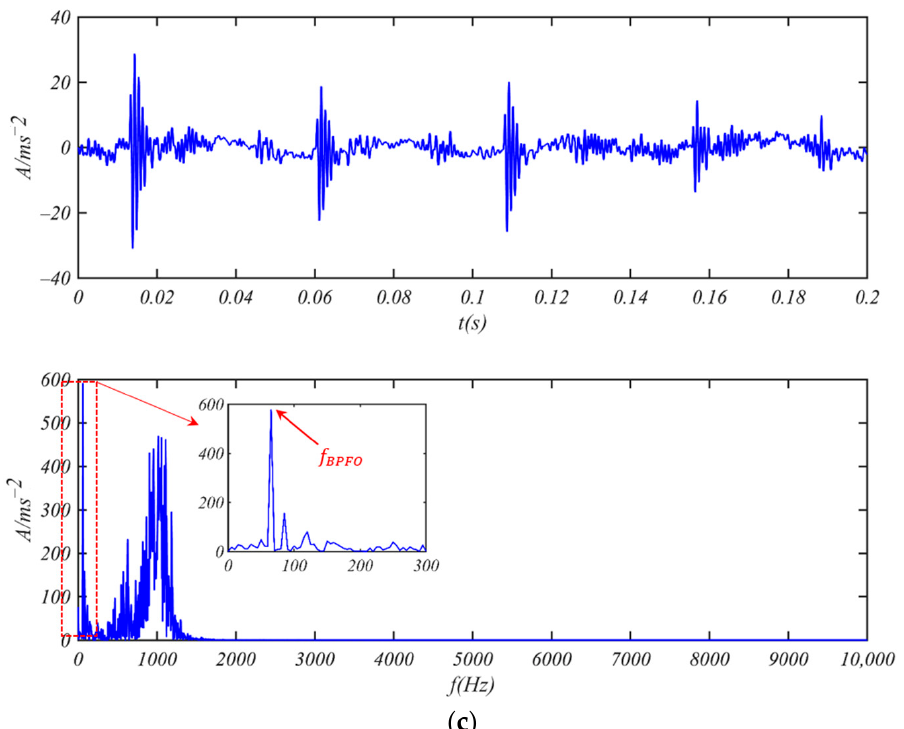
Figure 12. Comparison between different models to process bearing 6200 with outer ring fault: ( a ) origin time-domain waveform and spectrum; ( b ) time-domain waveform and spectrum processed by CBSR model; and ( c ) time-domain waveform and spectrum processed by PNABSR model.